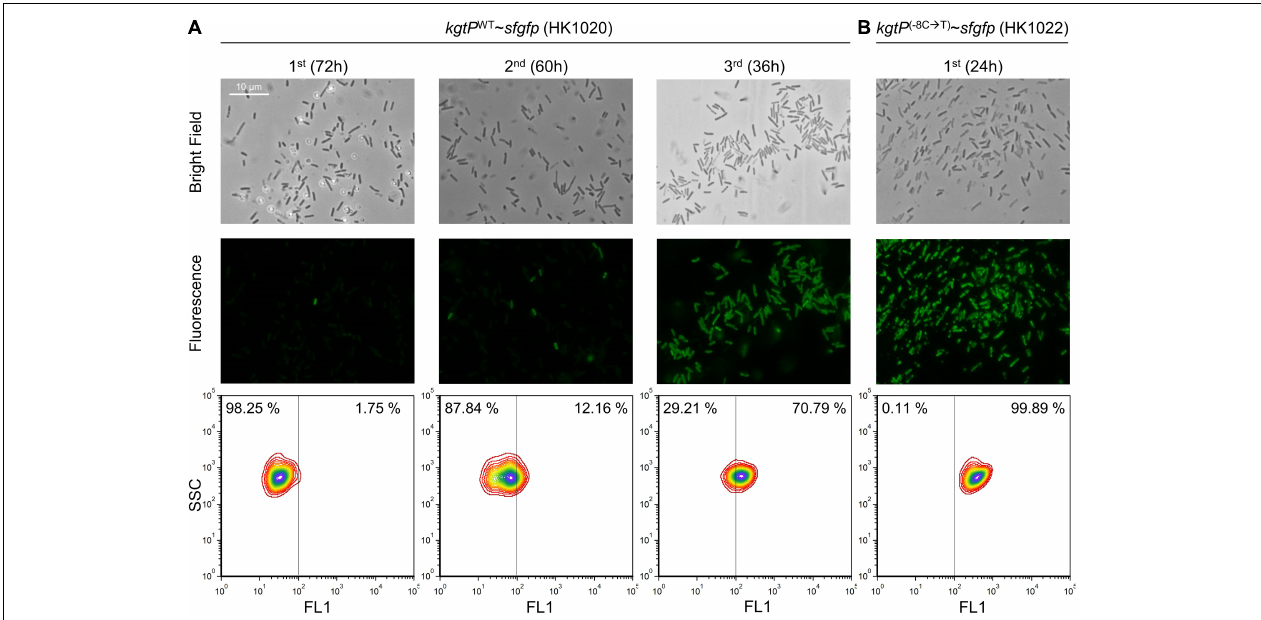
FIGURE 5 | Fluorescence analysis of the HK1020 ( kgtP WT ∼ sfgfp ) and HK1022 ( kgtP ( − 8C → T ) ∼ sfgfp ) cells grown in M9 succinate medium. The occurrence and the number of fluorescent cells in the HK1020 population were analyzed via microscopy (top: bright field, middle: fluorescence) and flow cytometry (bottom), respectively.